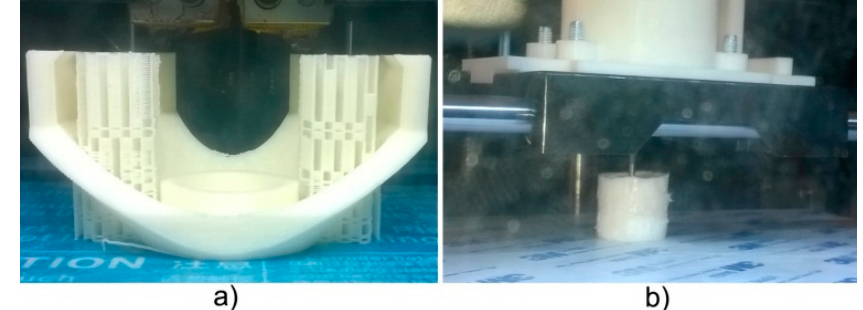
Figure 15. Parts 3D printed by the same machine ( a ) Extruder prototype component printed with ABS ( b ) Silicone sample part printed by paste extruder prototype. ( b ) Silicone sample part printed by paste extruder